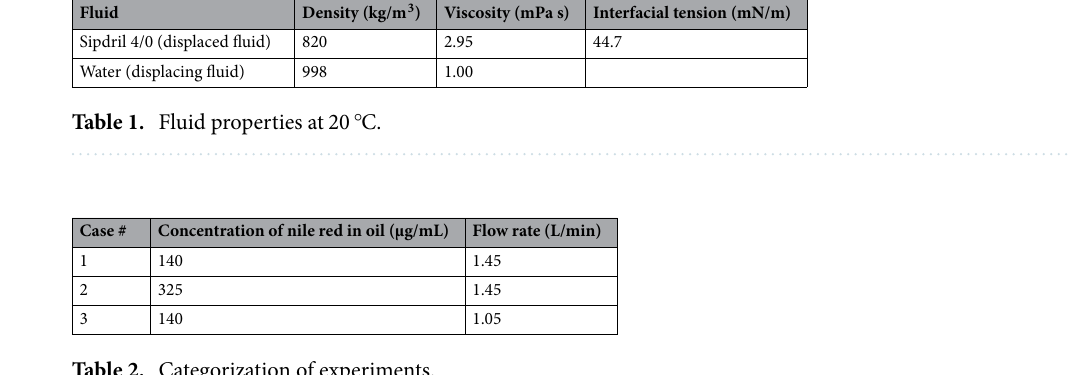
Table 2. Categorization of